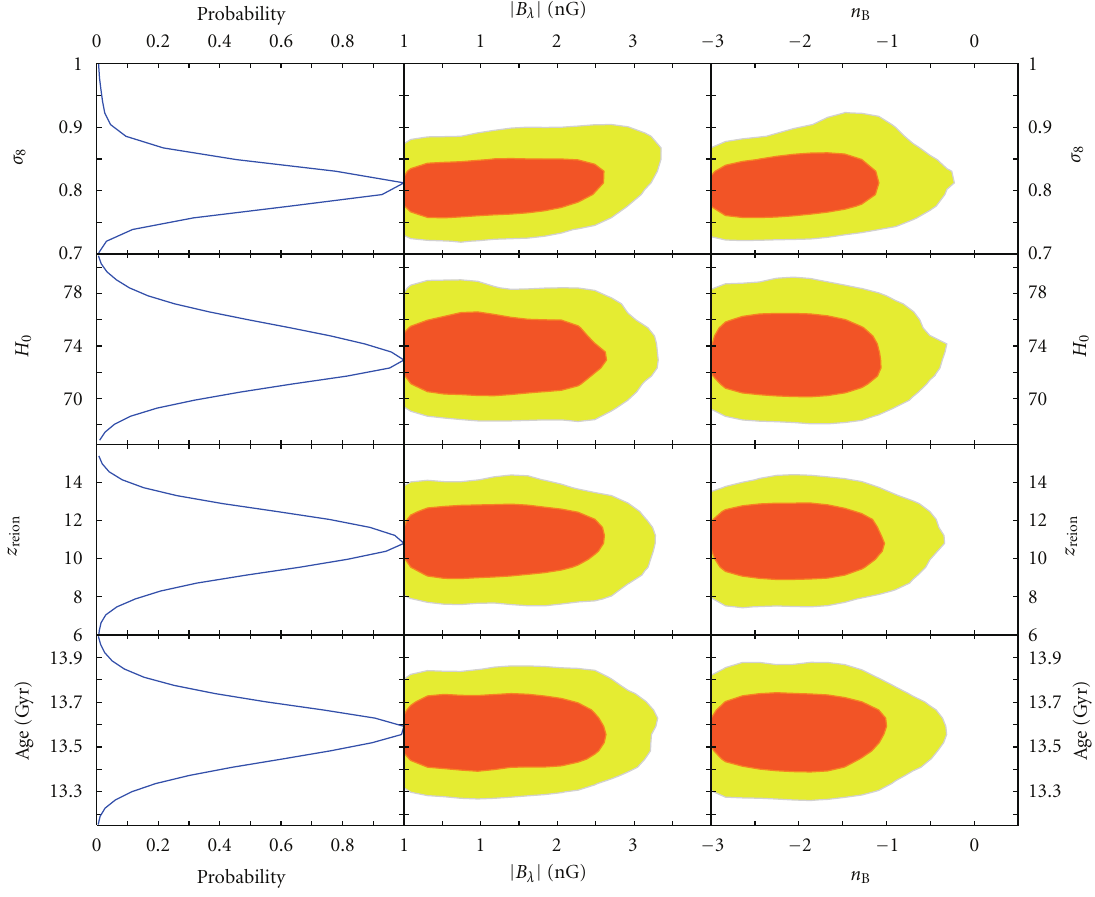
Figure 11: Probability distributions and contours of 1 σ and 2 σ confidence limits for the parameters σ 8 , H 0 , z reion , and Age. Orange contours show 1 σ (68%) confidence limits, and yellow contours show 2 σ (95%) confidence limits. Blue curves show probability distributions for each parameter. Note that these are not input priors, but output